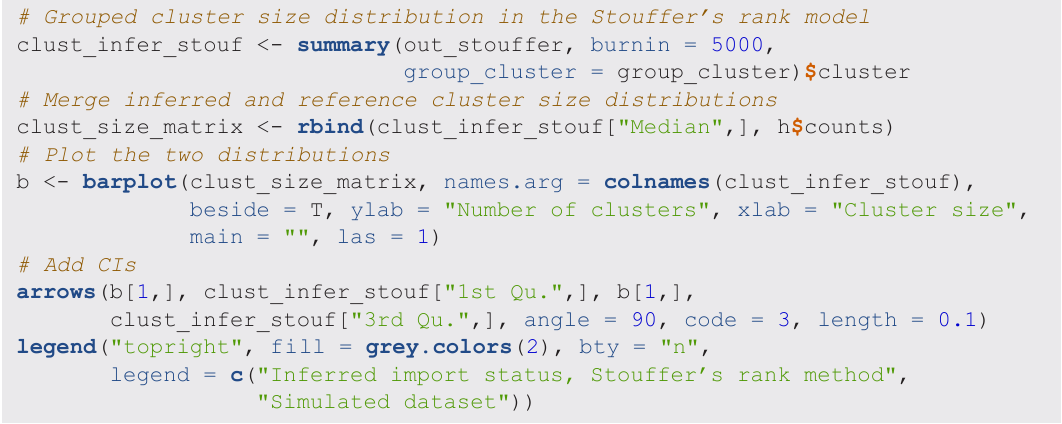
# Grouped cluster size distribution in the Stouffer’s rank